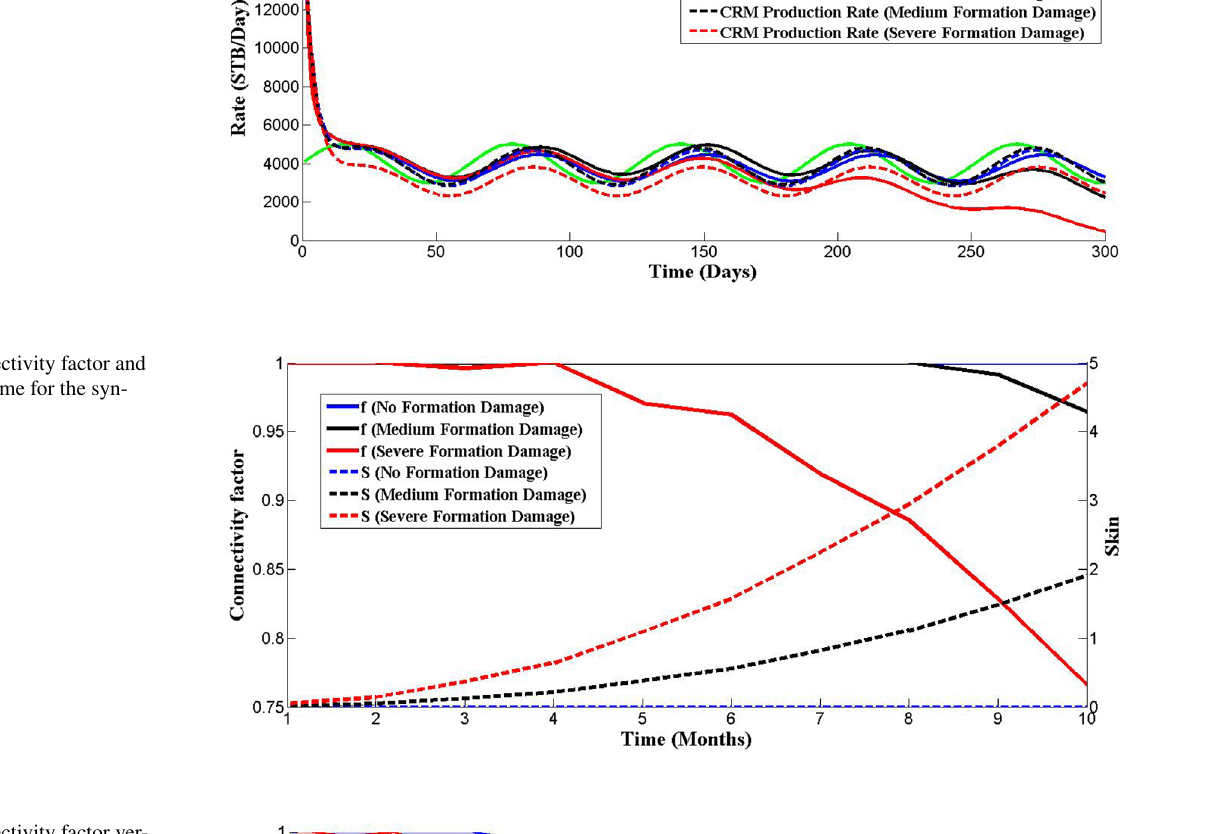
Fig. 4 Simulated and esti- mated (CRM) production rate in different formation damage conditions